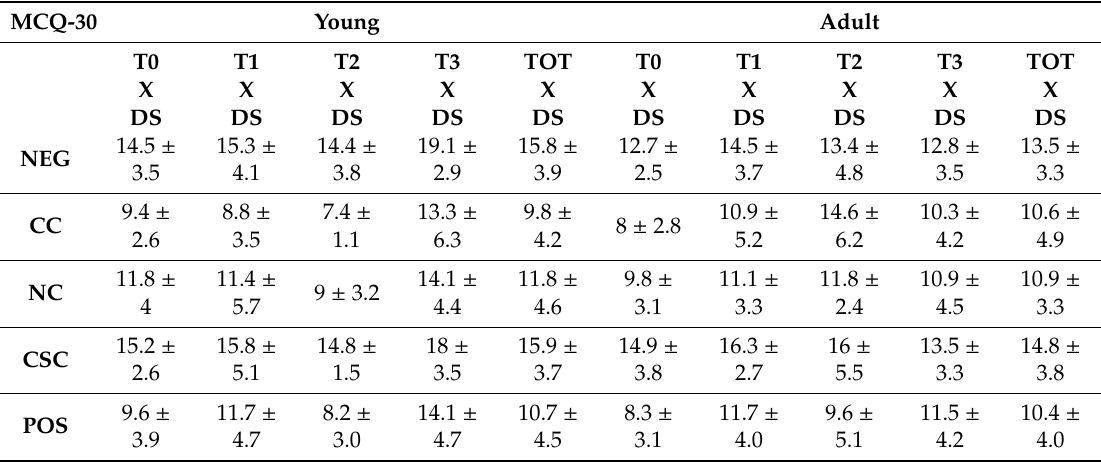
Table 3. Mean and standard deviations of the MCQ-30 sample distributed by age group and timing of evaluation. MCQ-30 Young